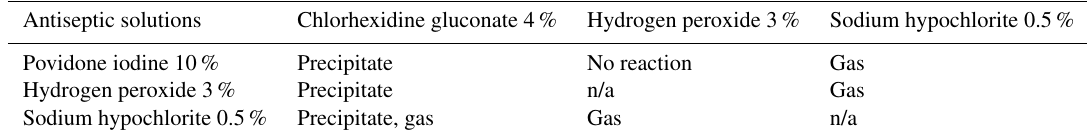
Table 3. Antiseptic combination